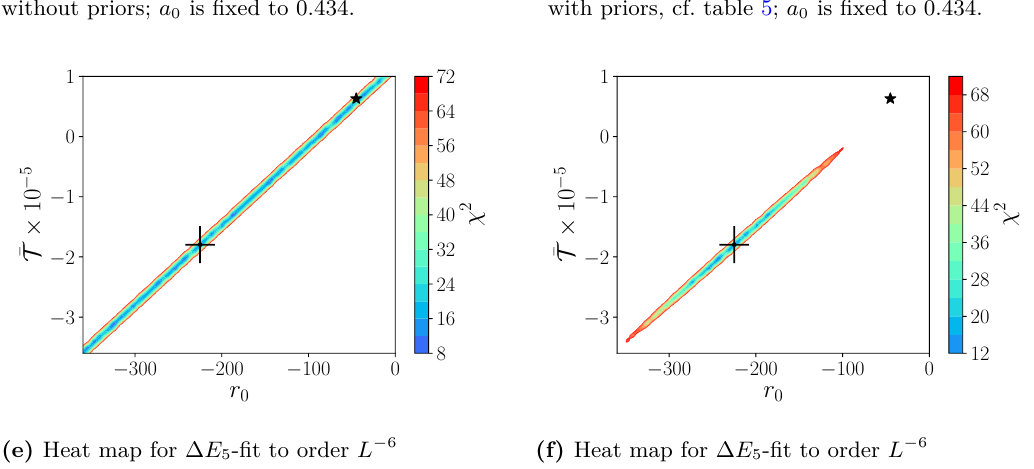
Figure 13. χ 2 heat maps a) to f) that correspond to the fits with EC as well as RC in the interval [9 , 24] for L . The black data points with error bars mark the respective results for r 0 and ¯ T from prior constrained fits, cf. table 5. The black stars correspond to the perturbative predictions, calculated from the fixed a 0 values by using eqs. (4.10) and